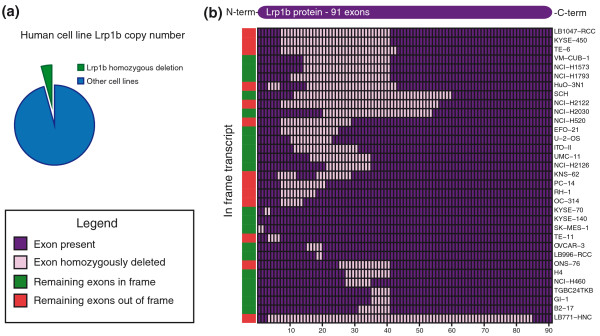
Human cell lines frequently carry homozygous deletions of the LRP1B gene. (a) Pie chart showing the proportion of the 770 cell lines containing homozygous deletions in the LRP1B gene. (b) Heatmap showing which exons of the LRP1B gene have been homozygously deleted. The x-axis shows the exons in transcriptional order. The y-axis shows the different cell lines, clustered using hierarchical Euclidean clustering on the deletion patterns. The color bar along the y-axis shows whether an in-frame transcript would remain if these exons have been deleted.